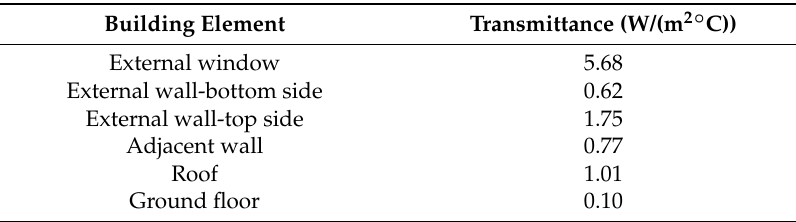
Figure 6. 3D thermal model of the swimming pool hall and adjacent buildings. Table 2. Transmittances of the hall building envelope.